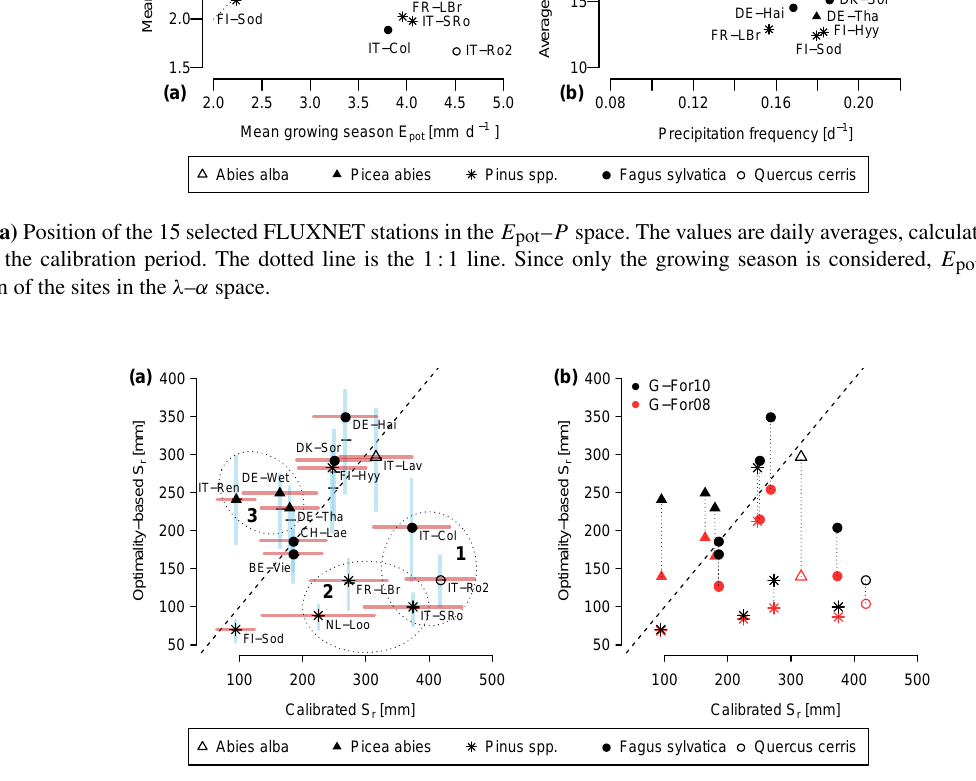
Figure 5. (a) Results of the optimality-based S r estimates obtained with G-For10, plotted against the calibration-based S r . The red horizontal bars show the standard deviation of the calibrated S r at each site. The point symbols show the S r estimates obtained with standard param- eterization, whereas the horizontal dashes show the median of estimates obtained with perturbed parameter values. The blue vertical bars extend to ± 1 standard deviation from the median. The ellipses show the cases with strong mismatches between G-For10 and calibrated S r , discussed in Sect. 4.2: Mediterranean climates (1), pine sites on sandy soils (2), and spruce sites along an elevational gradient (3). The dashed line is the 1:1 line. (b) Comparison between S r estimates obtained with G-For10 (same values as in a ), and S r values obtained using Guswa’s 2008 model (G-For08). At all sites, G-For08 estimates are lower than G-For10 estimates. The effect of water uptake strategy varies greatly across sites, with the largest differences occurring at energy-limited sites with a high water holding capacity (e.g., Lavarone,